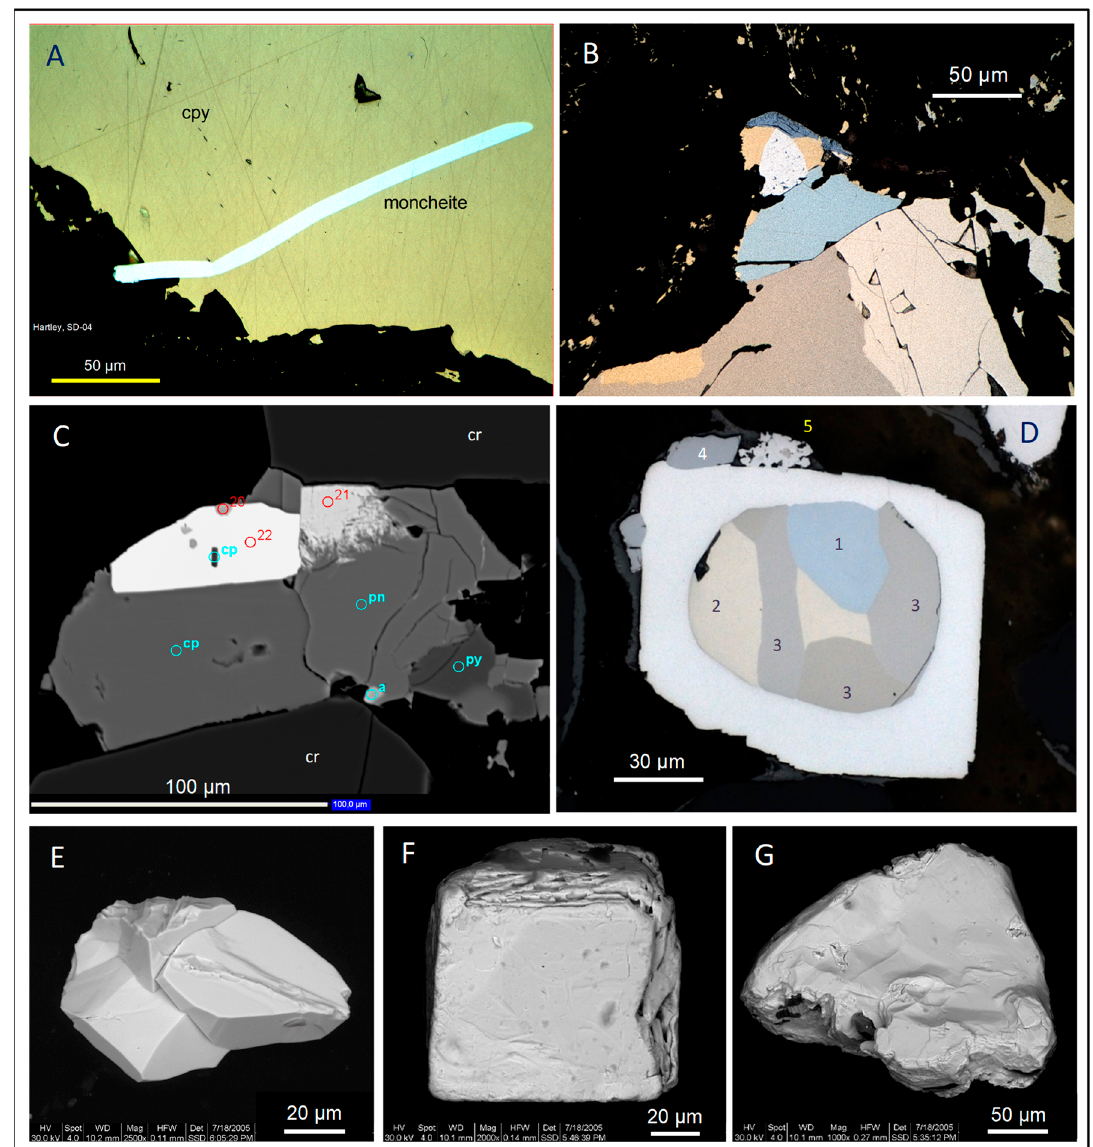
Figure 2. Platinum-group minerals (PGM), pristine ores, in reflected light, oil immersion ( A , B , D ), Backscatter electron (BSE) image ( C ), and BSE images of PGM grains from pristine ores of the Main Sulfide Zone, Great Dyke, extracted by electric pulse disaggregation, EPD ( E – G ). ( A ) Lath of moncheite in chalcopyrite (cpy). MSZ, Hartley Mine. ( B ) Aggregate of pyrrhotite (brownish) and pentlandite (cream-white) at bottom part, overgrown by braggite (bluish), grain of moncheite (white, soft) partly surrounded by chalcopyrite (yellow), and molybdenite (gray, crocodile-shaped). MSZ, Hartley Mine. ( C ) Sulfide aggregate between two chromite grains (cr) consisting of chalcopyrite (cp), pentlandite (pn), and pyrite (py). White grain on top is cooperite/braggite (22) intergrown with malanite (light grey, 21). Merensky Reef, Garatau, eastern Bushveld. ( D ) Composite grain of Pt–Fe alloy (white rim; Pt 65 Fe 30 ), geversite [PtSb 2 ] (1, bluish), stumpflite [Pt(Sb,Bi)] (2, yellowish), genkinite [(Pt,Pd) 4 Sb 3 ] (3, light brown), sperrylite (4), and tulameenite [Pt 2 CuFe] (5). Driekop Pipe, eastern Bushveld. ( E ) Sperrylite crystal. ( F ) Pt–Fe alloy. ( G ) Moncheite.